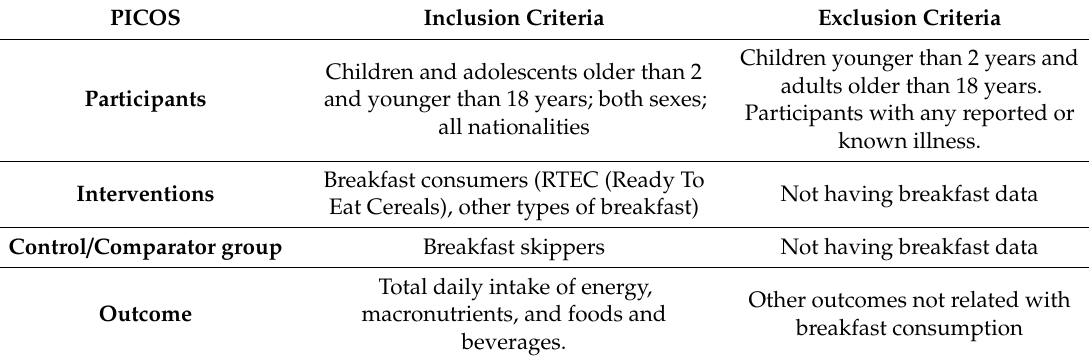
Table 1. PICOS (Participants, Interventions, Control, Outcomes) criteria used for the inclusion and exclusion of